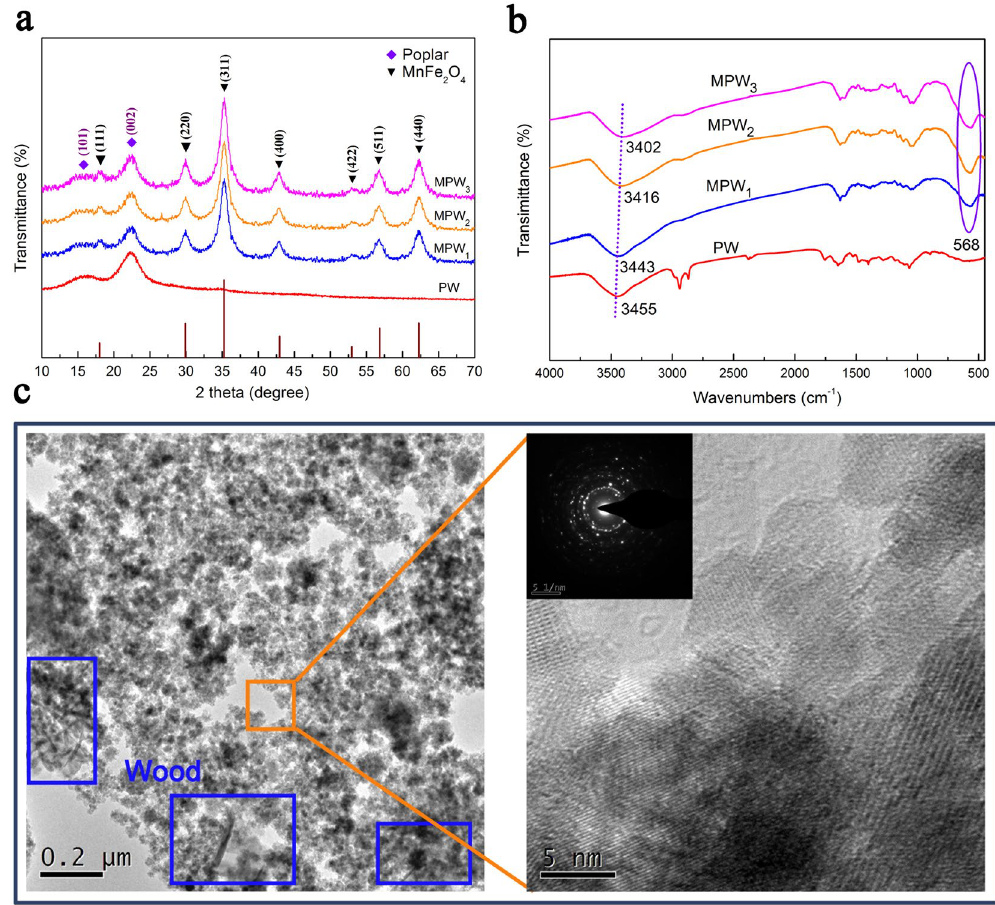
Figure 1. ( a ) XRD patterns and ( b ) FT-IR spectra of PW, MPW 1 , MPW 2 and MPW 3 ; ( c ) TEM images of MPW 2